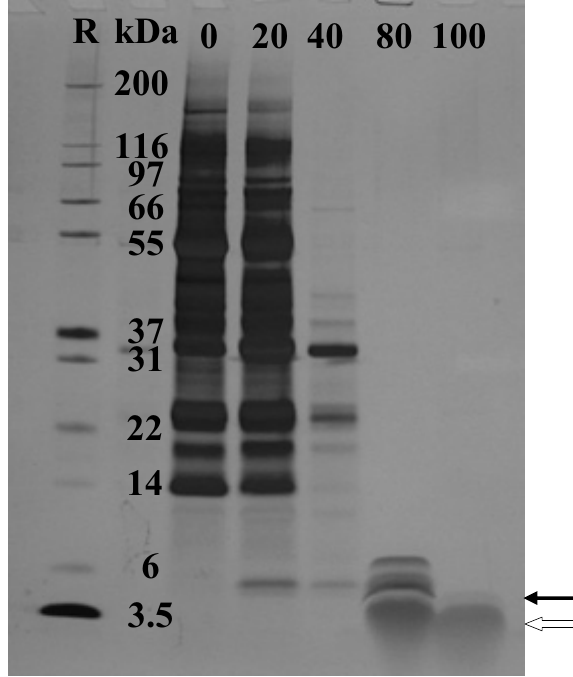
Fig. 3. – NuPAGE ® (Novex 4-12 %) of five acetone-soluble fractions of spiderwort Cp-rich leaf cells extracted with different concentra- tions of acetone (0 %, 20 %, 40 %, 80 % and 100 %). Molecular mass markers (M) are shown on the left. 7 : acetone- soluble low molecular weight protein bands were isolated from the 20 %, 40 %, 80 % and 100 % acetone-soluble fractions. : broad green band of